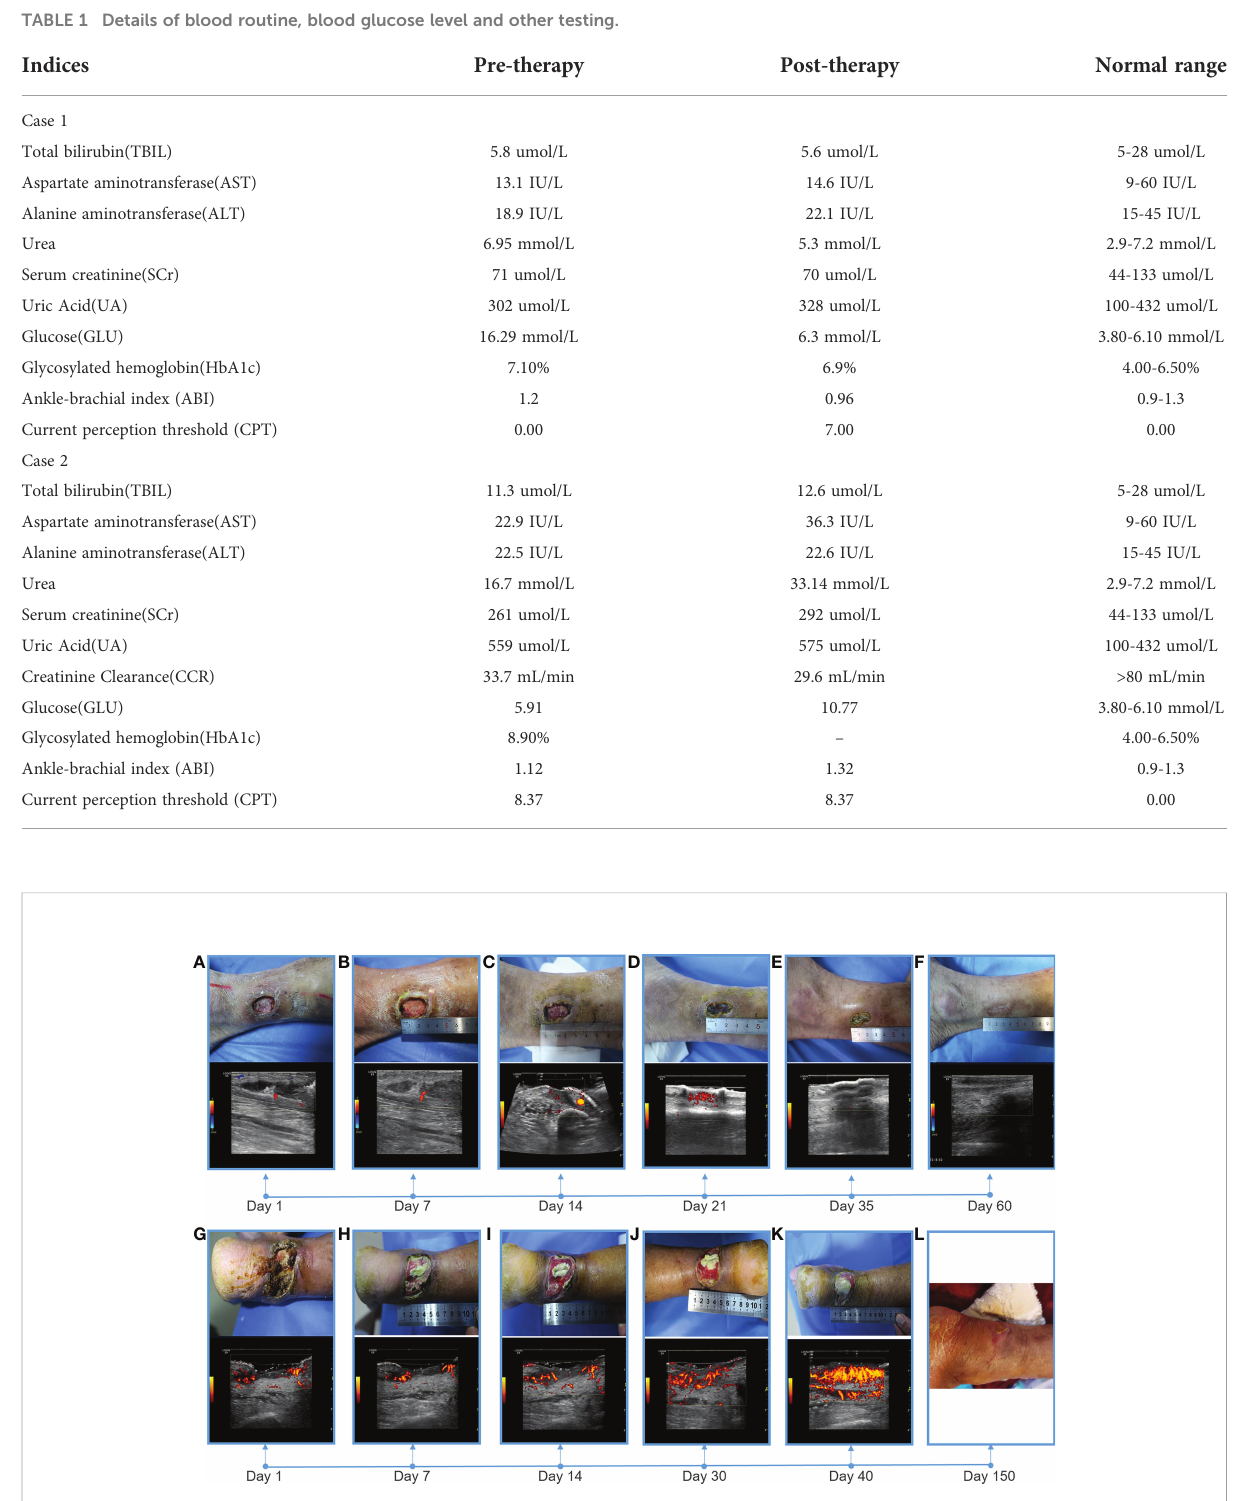
FIGURE 2 Showing of skin wounds and CDFI or PDI ((Power Doppler Imaging)) ultrasound imaging for progress in the treatment of diabetic lower extremity ulcers in two cases. Wound conditions at the (A) 1th, (B) 7th, (C) 14th, (D) 21th, (E) 35th, and (F) 60th day of post therapy showed the gradual healing of ulceration for case 1; Wound conditions at the (G) 1th, (H) 7th, (I) 14th, (J) 30th, (K) 40th, and (L) 150th day of post therapy showed the gradual healing of ulceration for case 2. PDI showed that the blood fl ow of the soft tissue around the ulcer gradually increased, and the blood fl ow was very abundant before healing.